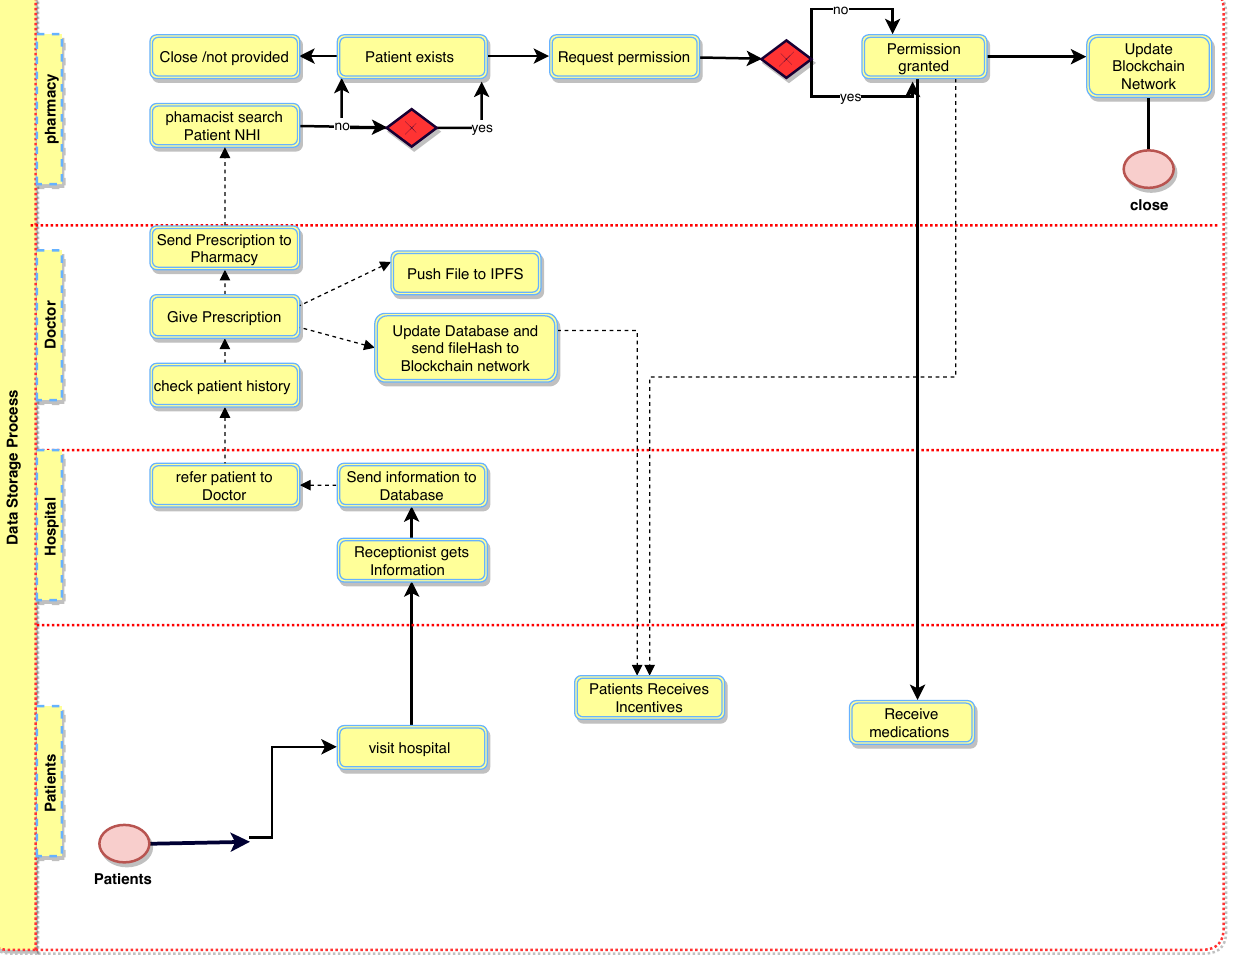
Figure 5. BlockPres data storage process. Algorithm 2: Accessing patient’s record from a different healthcare